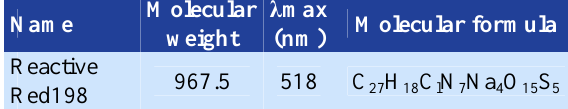
Table 1. The characteristics of Reactive Red 198 dye 17